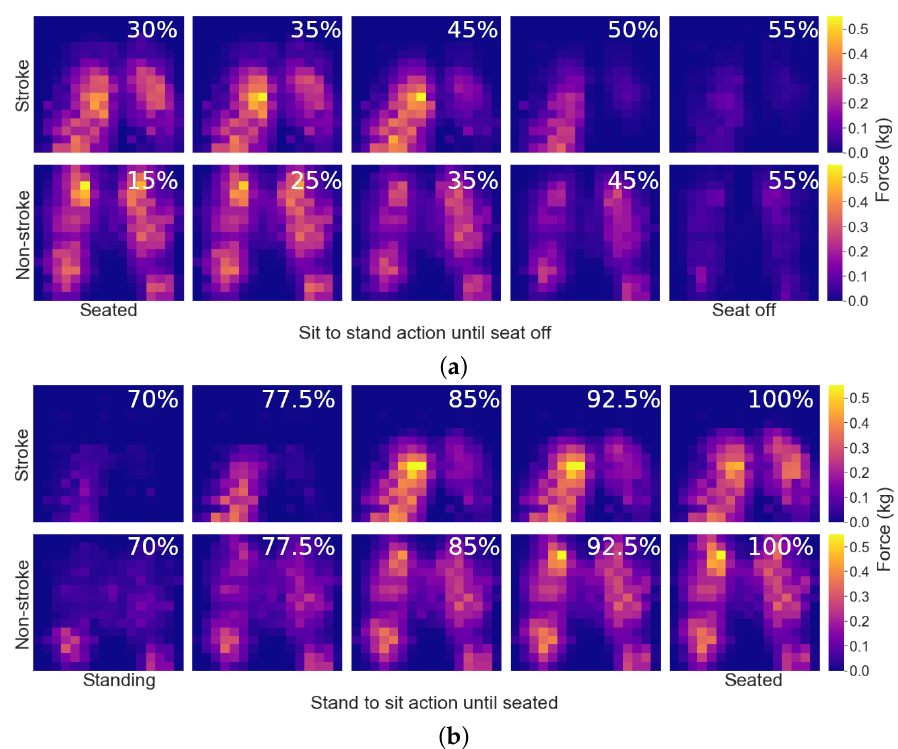
Figure 6. Average weight distribution on seat mat during ( a ) sit-to-stand action, and ( b ) stand-to-sit actions. Each sensor reading weight is in kg. Percentage progress through movement is highlighted in